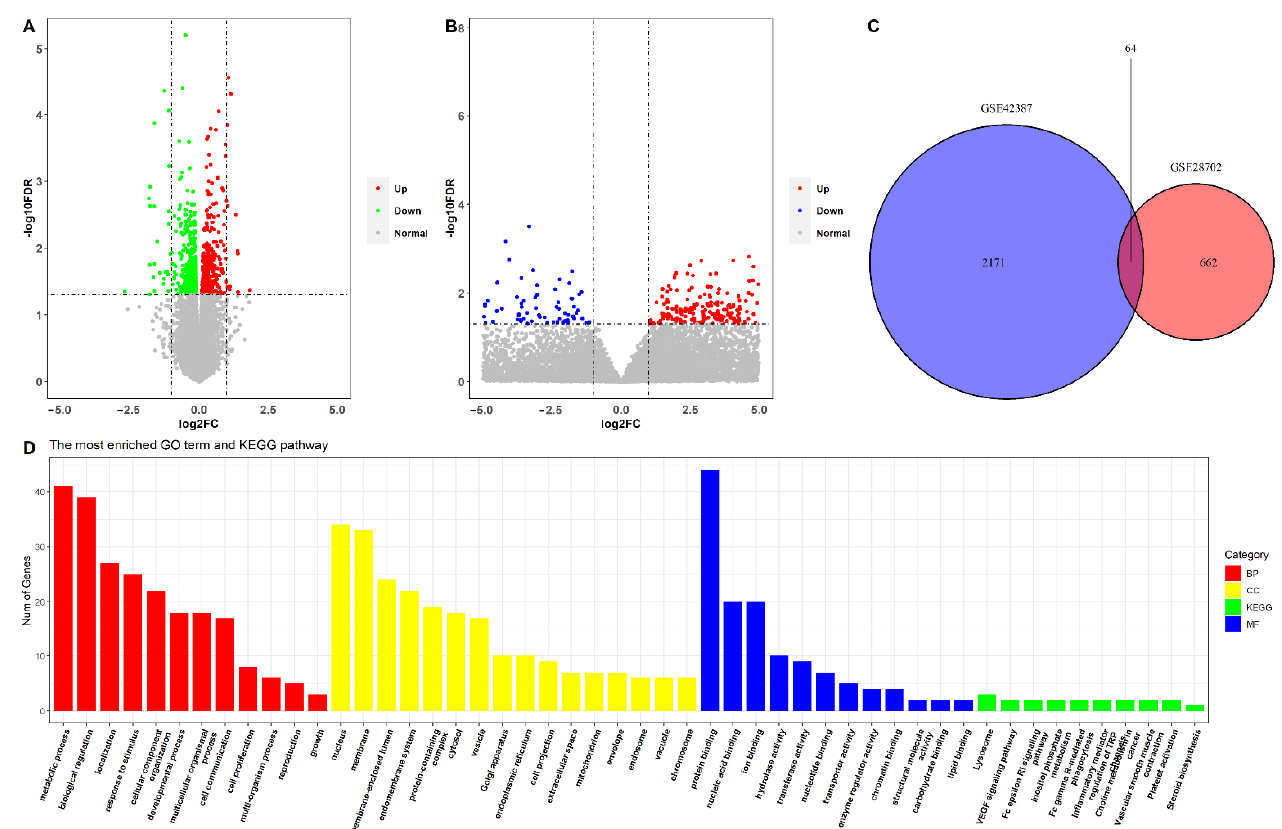
Figure 1. Identification of oxaliplatin resistance-related DEGs. ( A ) Volcano plot of differential expression genes (DEGs) between oxaliplatin-resistant and oxaliplatin-sensitive cells; ( B ) volcano plot of DEGs between non-responder and responder patients who underwent FOLFOX6 chemotherapy; ( C ) Venn plot of the oxaliplatin resistance-related DEGs from cells and clinical samples; ( D ) functional enrichment of oxaliplatin resistance-related DEGs.